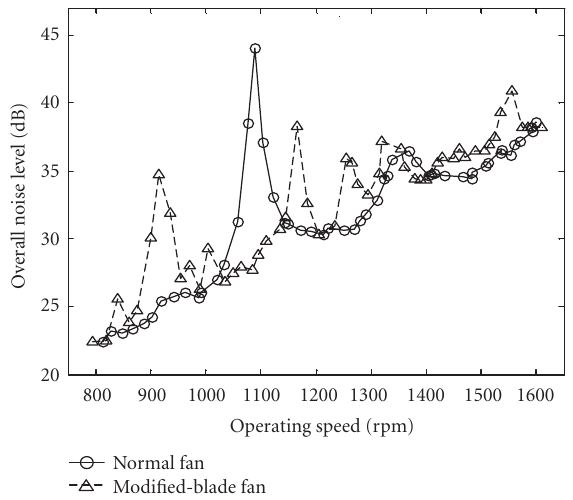
Figure 9: Noise level of normal fan and modified-blade fan system.